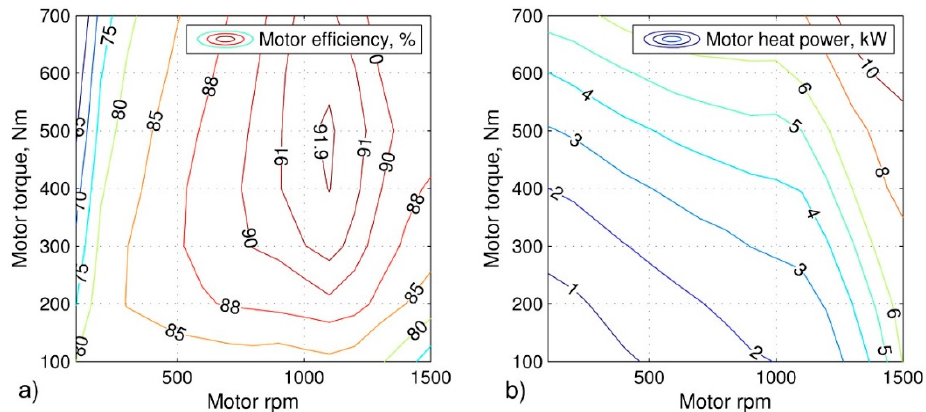
Figure 4. Characteristics of the in-wheel motor: ( a ) Efficiency and ( b ) dissipated heat power.